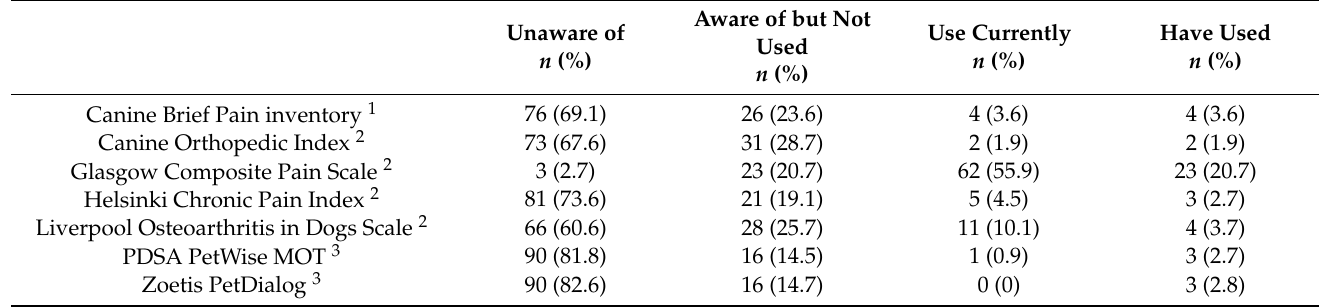
Table 2. Number and percentage of veterinary professionals surveyed who are aware of and who use/have used selected pain and quality of life (QOL) scoring/assessment tools. Aware of but Unaware of